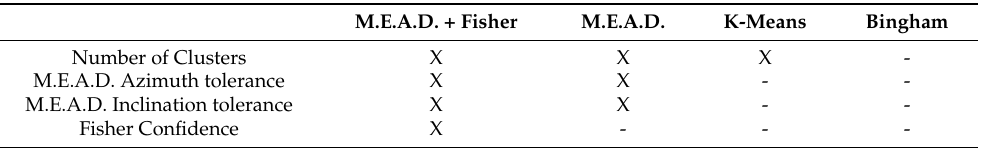
Table 1. Influences of user-controlled parameters on ArcStereoNet (ASN) algorithms. An ‘X’ symbol means that the parameter (row) has an effect on the algorithm